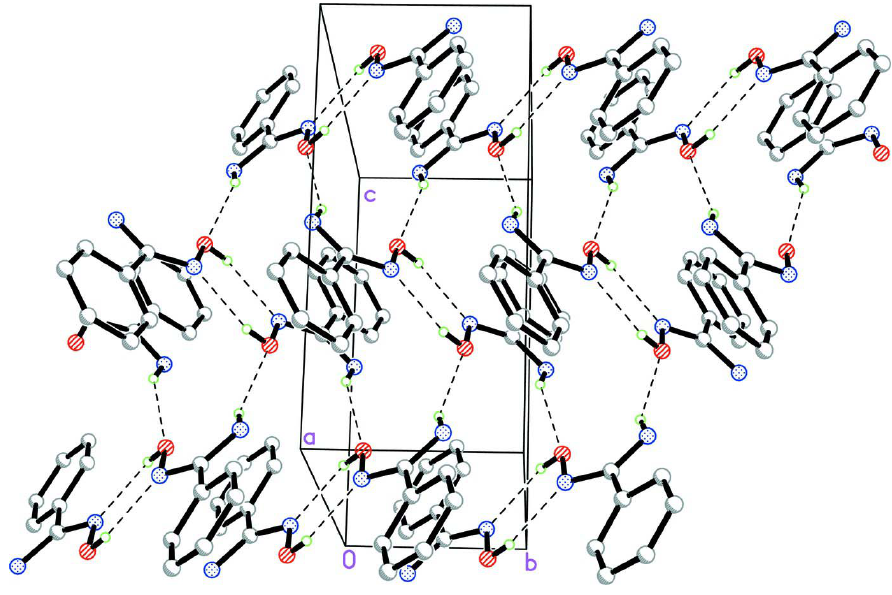
Figure 1 The molecular structure of I showing the atom numbering scheme with displacement ellipsoids at the 30% probability level.